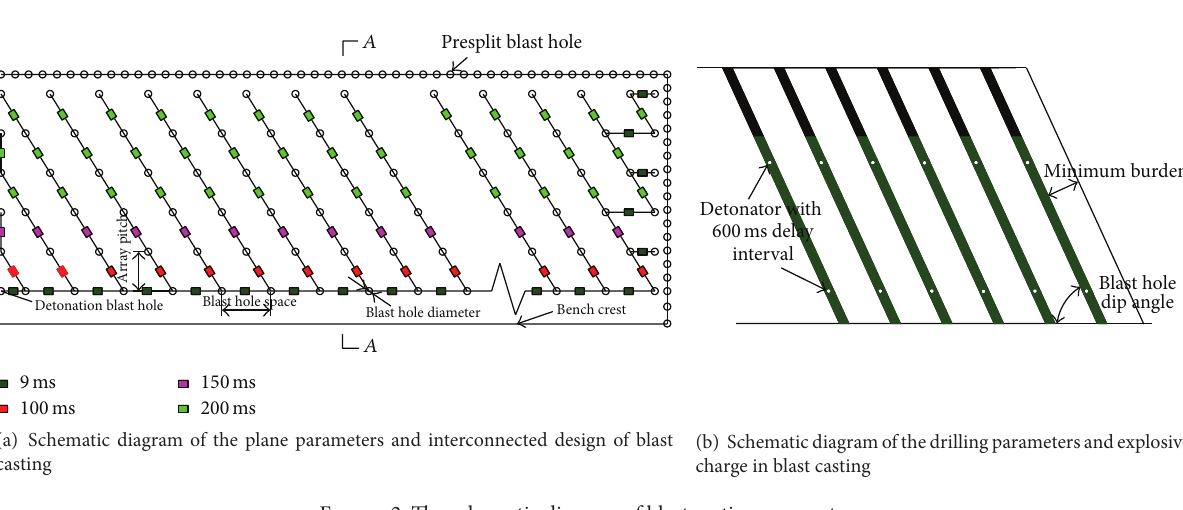
Figure 2: The schematic diagram of blast casting